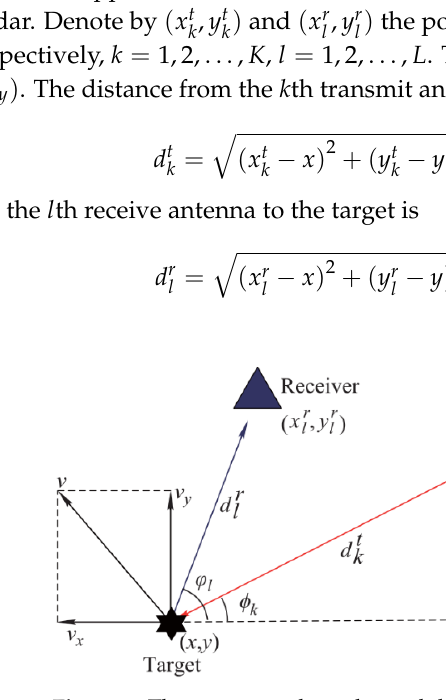
Figure 1. The geometry the radar and the target